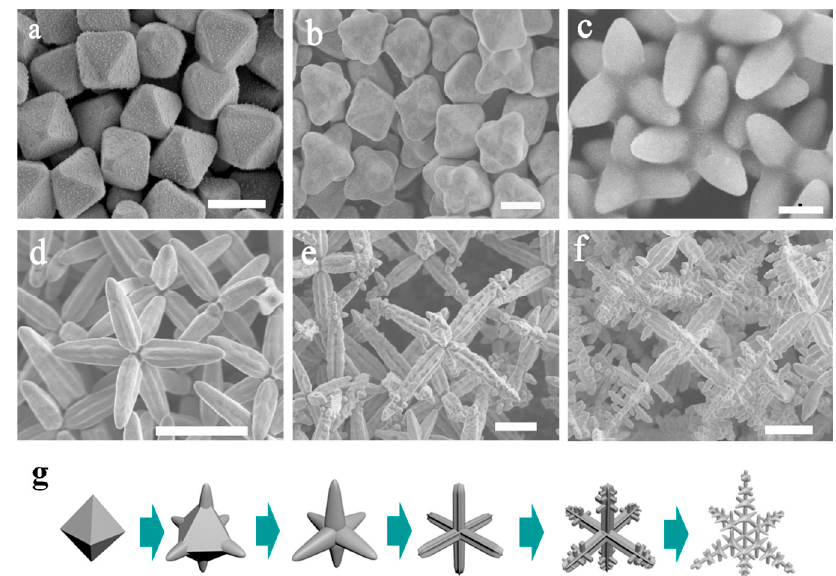
Figure 2. ( a – f ) SEM images of AgCl microcrystals for different amount of DDA ( a ) 0.4 mL; ( b ) 0.5 mL; ( c ) 0.7 mL; ( d ) 0.8 mL; ( e ) 0.9 mL and ( f ) 1 mL. ( g ) Illustration of shape